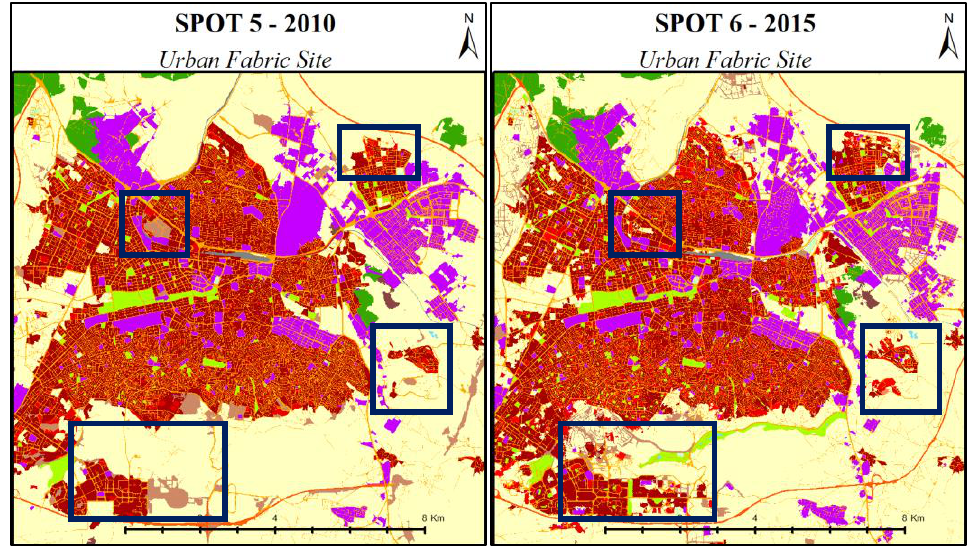
Figure 5. Changes in land use/cover for residential sites with boxes (a) 2010 SPOT 5, (b) 2015 SPOT 6 Gaziantep is the one of the major cities of Turkey in industrial sector, which was also impacted land cover/use changes within the city. Total area of Industrial areas was 0.28 km2 in 2010 but 0.34 km2 in 2015 showing an increase of 21%. New industrial sites have been established in the north of the city centre within five years (Figure